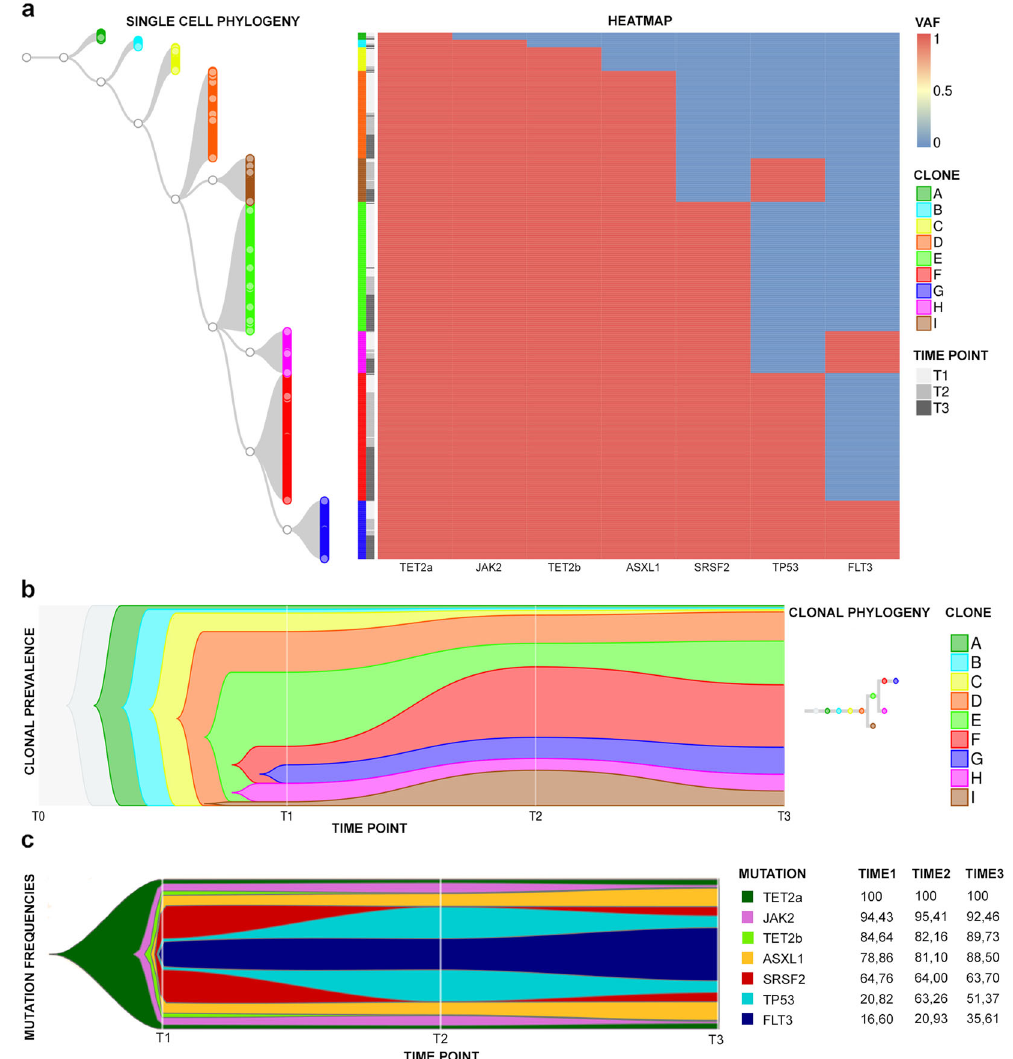
Fig. 1 Single-cell phylogeny and mutation acquisition order. a The phylogenetic tree of the most represented clones identi fi ed in T1, T2, and T3. On the left is shown the tree starting from the founder cell carrying a single TET2a mutation (clone A). From the parental TET2a mutated cell, 8 clones originate (B – I) and each clone is represented by a speci fi c color; nodes are represented as white circles. On the right is the heatmap showing the mutational event (blue: wild-type, red: mutated) of the genes indicated at the bottom. Each cell in the phylogenetic tree corresponds to a row in the heatmap, identifying its mutational pro fi le. In b , the fi shplot indicates the abundance of 9 clones (A – I), identi fi ed in a , and their temporal evolution. Each clone is represented by the same color used in a . In particular, F clone in red and I clone in brown represent TP53 -mutated clones, while G clone in blue and H clone in purple represent FLT3 -mutated ones. In c , the fi shplot indicated the variation of mutation frequencies through time and the mutational acquisition order. Each variant is represented by a color. On the right, the table summarizing the mutation frequencies in single cells during time is